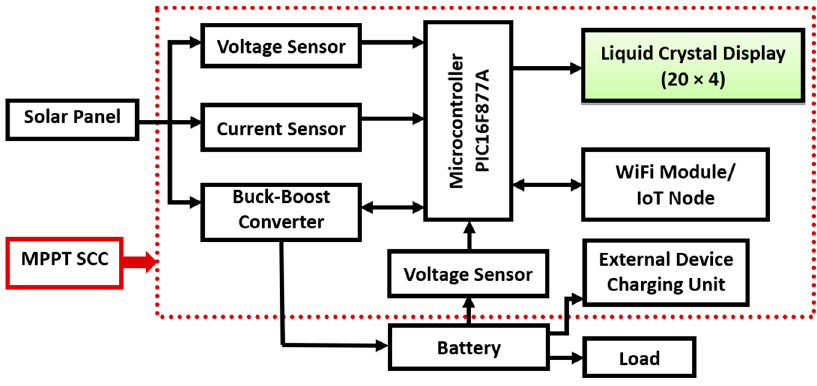
Figure 3. Proposed block diagram of the MPPT solar charge controller (SCC).